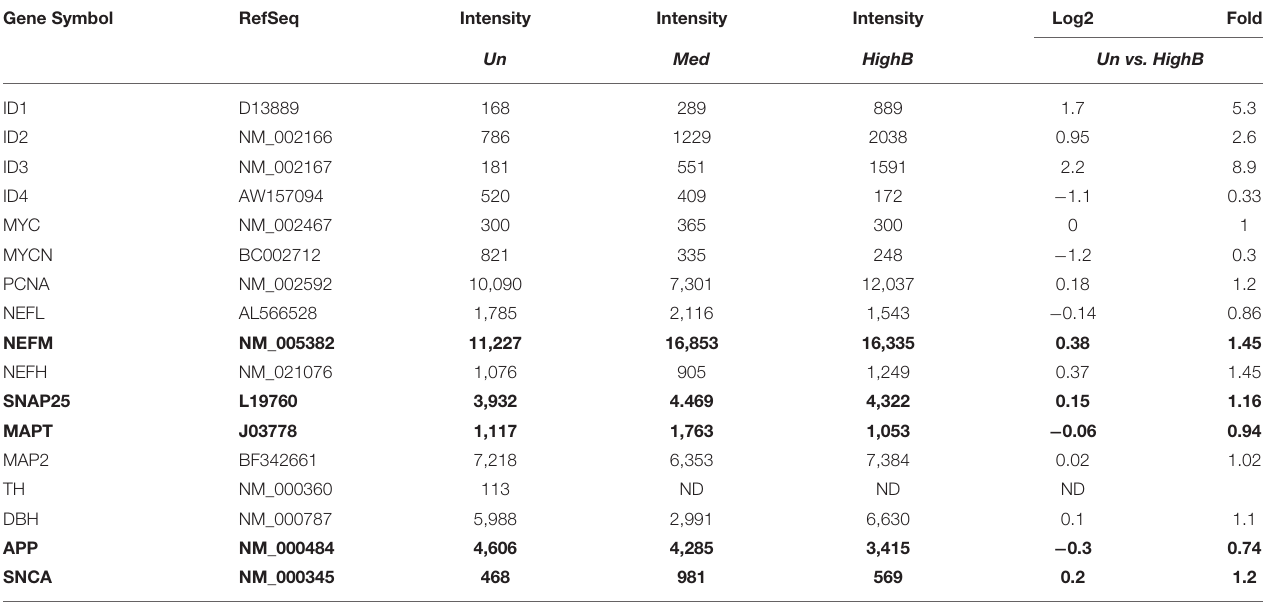
TABLE 7 | Differential expression of genes associated with neuronal structure and differentiation. Gene Symbol RefSeq Intensity Intensity Intensity Log2 Fold